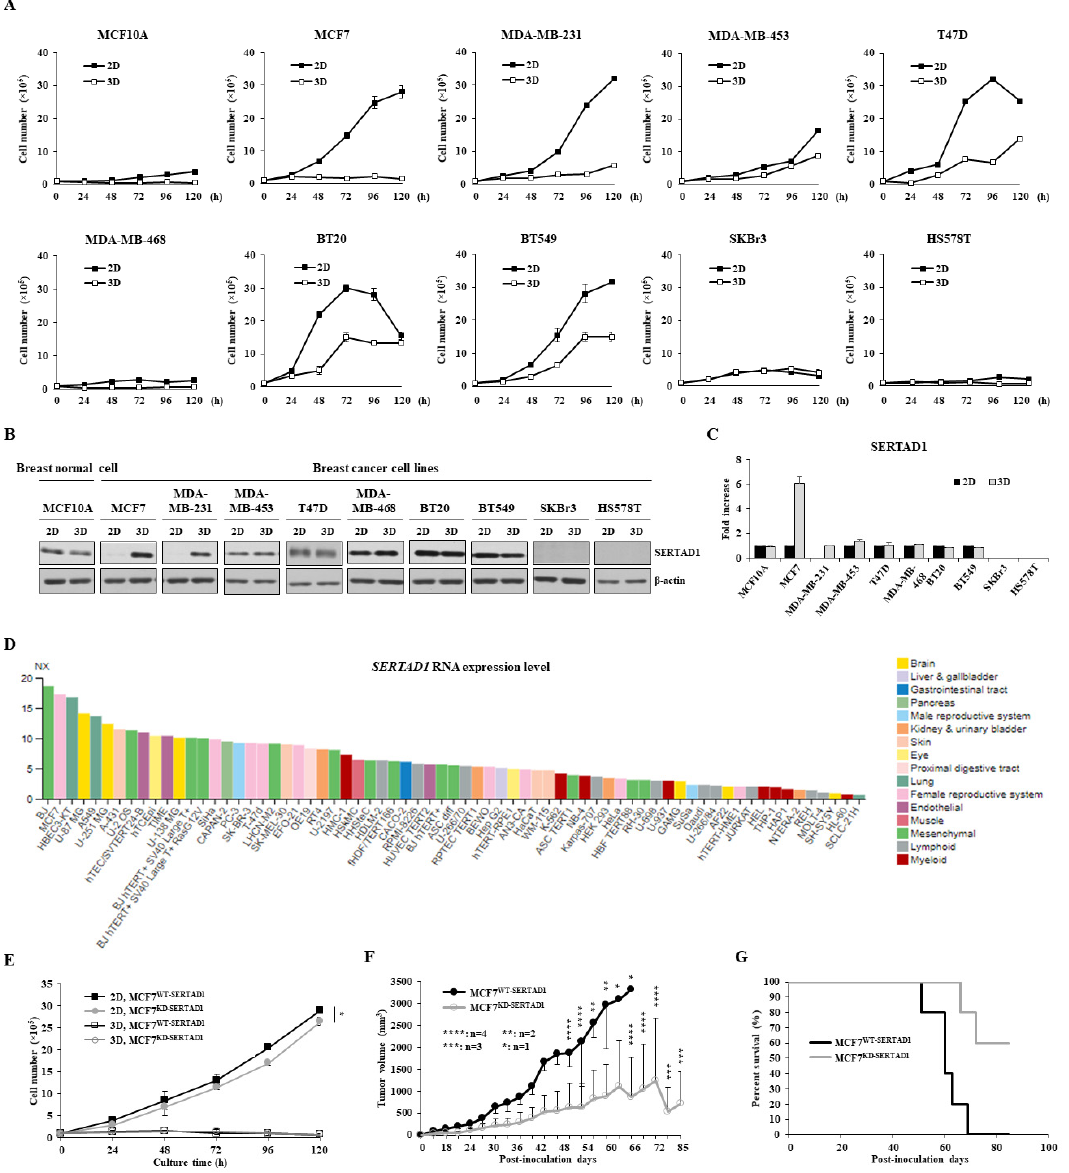
Figure 1. Cell viability of various breast cell lines in response to monolayer culture and suspension culture. ( A ) Cell proliferation of breast cell lines in 2D and 3D culture systems. Cell viability of each cell line was measured using trypan blue-staining assay every 24 h. Data are presented as mean ± SD based on three independent experiments. ( B , C ) Western blot analysis of SERTAD1 expression in 2D and 3D cell culture systems. Cells were cultured for 48 h and then lysed for immunoblotting. Data are representative of three independent experiments with similar patterns. ( D ) SERTAD1 mRNA expression overview in human cancer cell lines in the Human Protein Atlas [18]. Data summary images were obtained from: https://www.proteinatlas.org/ (version 20.1), via: https://www.proteinatlas.org/ENSG00000197019-SERTAD1/cell (accessed on 25 July 2020). ( E ) Cell growth of the two stable cell lines—MCF7 WT-SERTADl and MCF KD-SERTADl in 2D and 3D culture conditions using trypan blue-staining assay. Data are presented as the mean ± SD from three independent experiments. ( F , G ) Tumor volumes and survival rates of xenograft mice implanted with MCF7 WT-SERTADl or MCF KD-SERTADl .